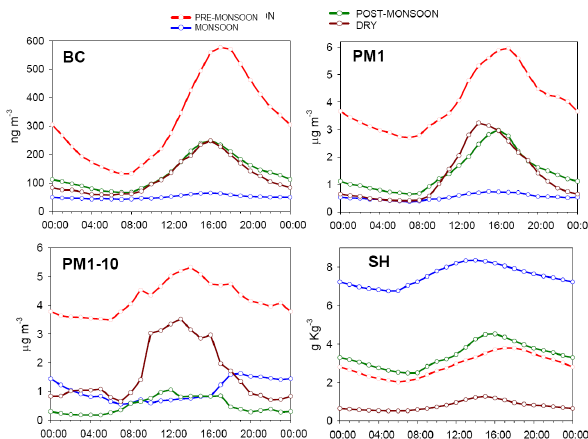
Fig. 4. 2-year seasonal diurnal variation of BC, PM 1 , PM 1 − 10 and specific humidity (SH) at NCO-P: pre-monsoon (red), monsoon (blue), post-monsoon (green) and winter (brown).